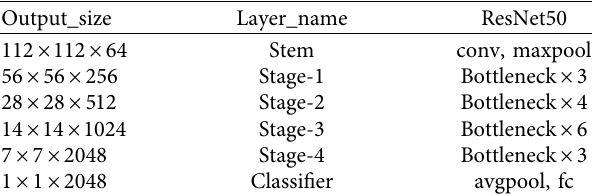
Table 1: The network structure of